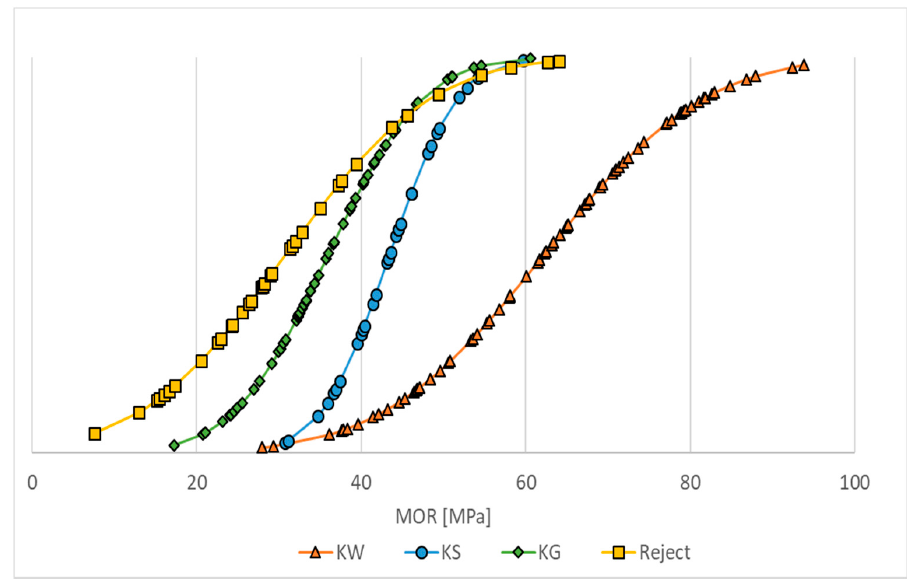
Figure 4. Cumulative distribution of static bending strength for Scots pine timber, taking strength grades into account.